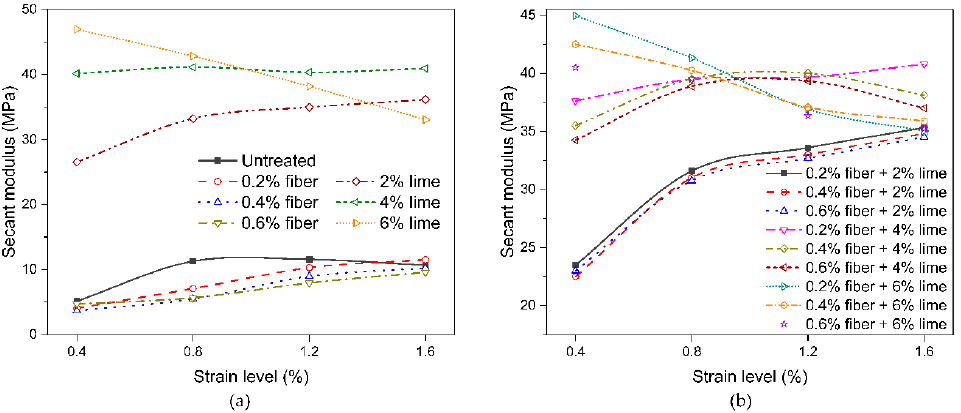
Figure 4. Secant moduli at four strain levels tested at σ 3 = 200 kPa: ( a ) samples reinforced with fibers or stabilized with lime and ( b ) fiber-reinforced samples stabilized with lime.